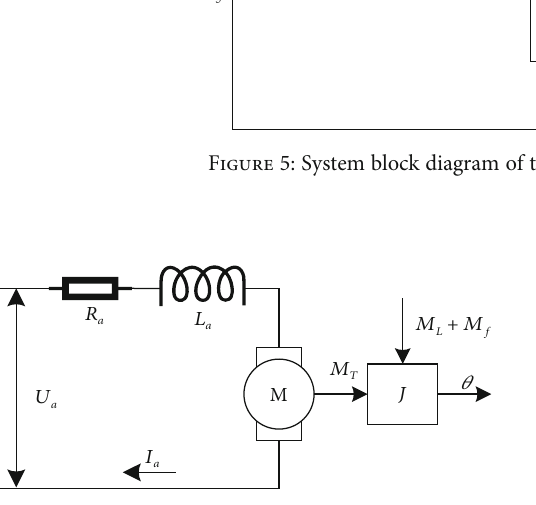
Figure 6: Schematic of the DC motor in a fl ow